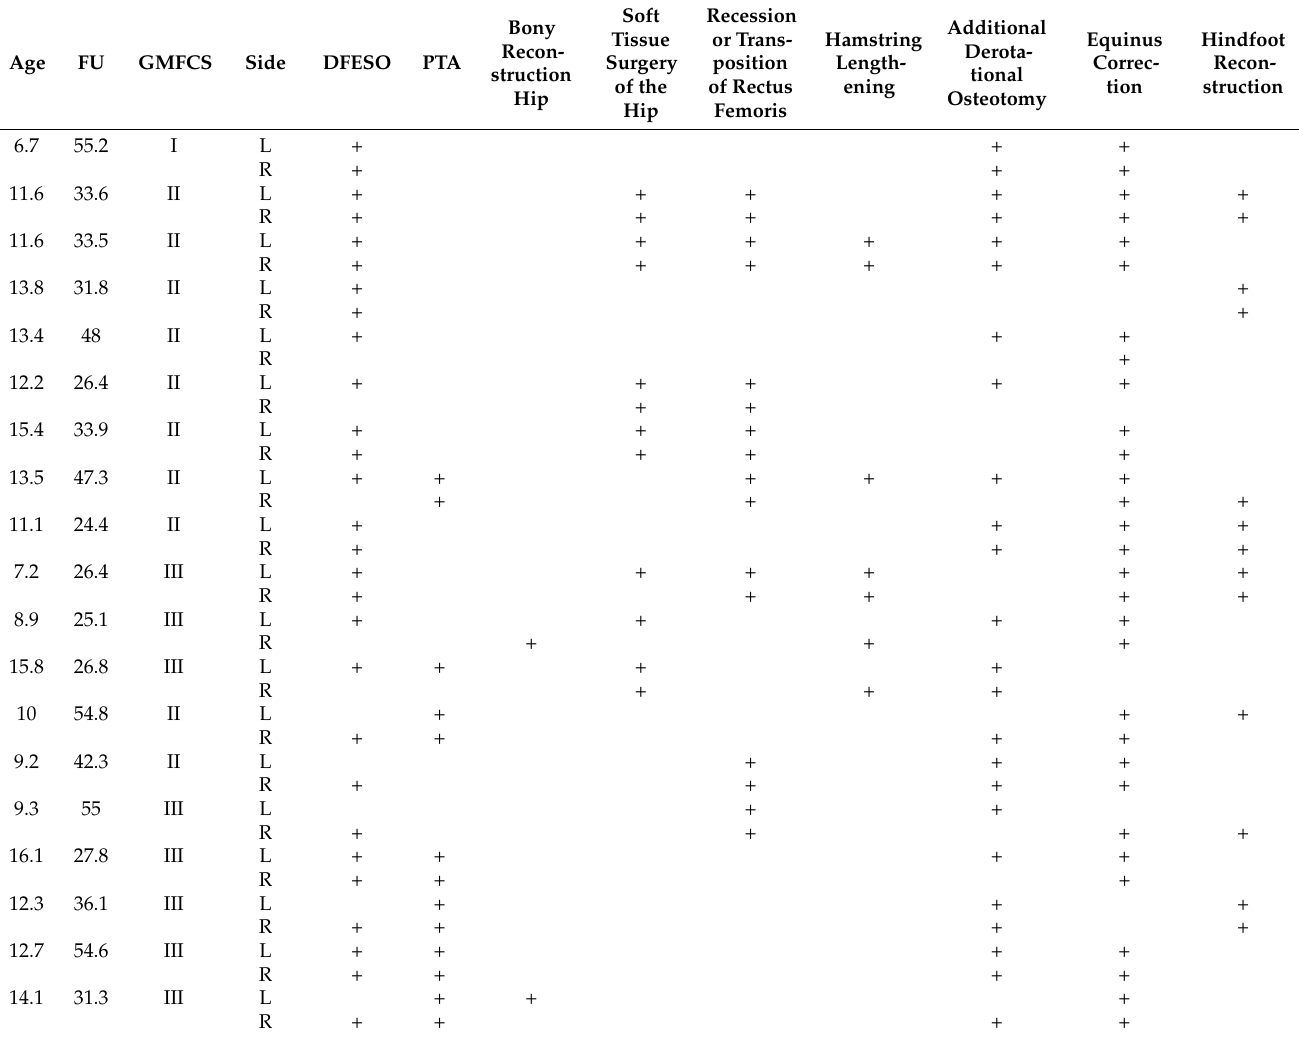
Table 1. Overview of the retrieved data of patients included in our